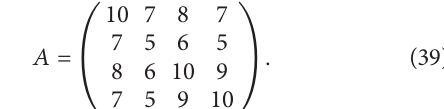
Table 1: Results of comparisons for Example 1. Methods